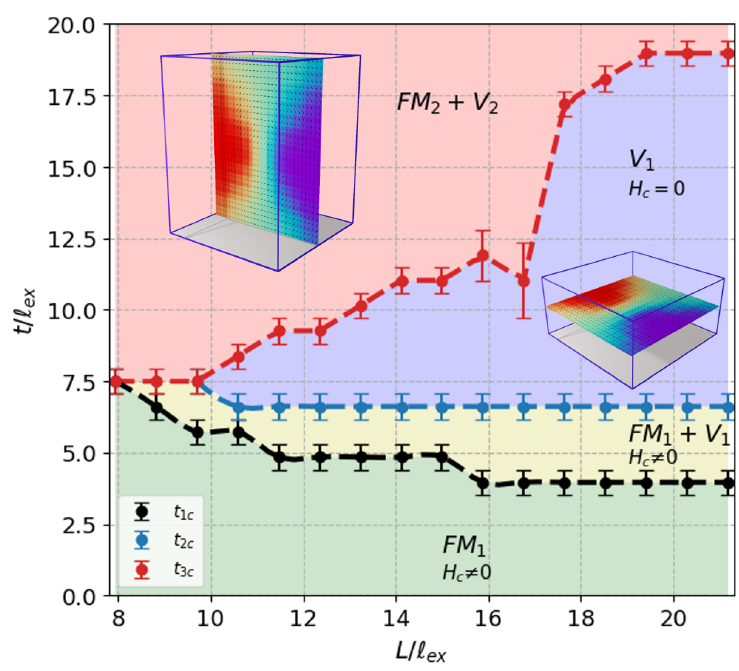
Figure 8. Field − driven magnetic phase diagram t vs. L in reduced units of the exchange length for an in-plane field applied along the x -direction. Four different phases can be identified, which are labeled as FM 1 , FM 1 + V 1 , V 1 and FM 2 + V 2 . The typical shapes of the M − H curves associated with these phases are those shown in Figures 1 and 6,